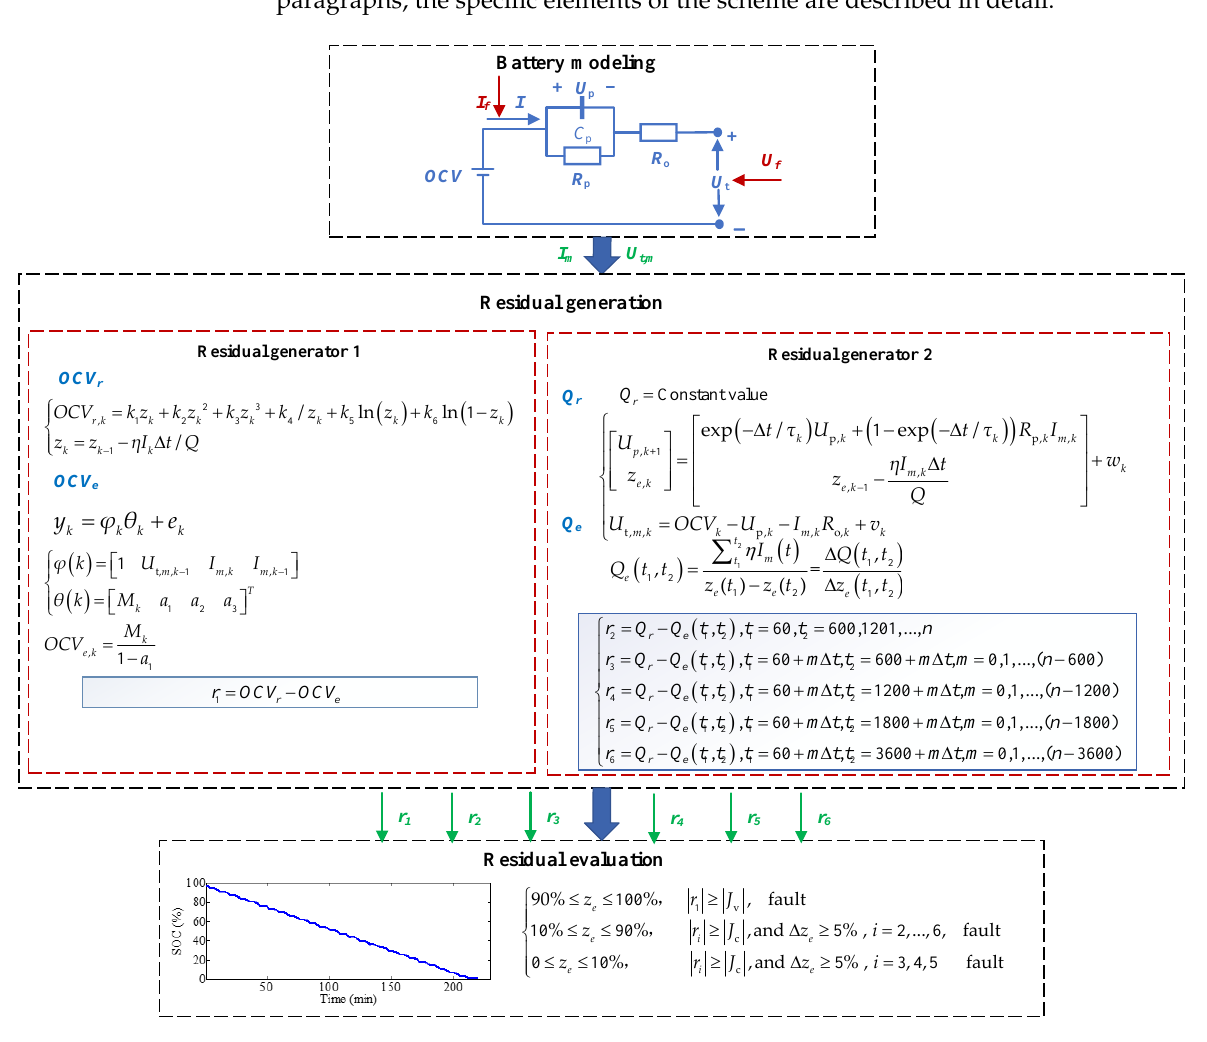
Figure 2. Sensor fault diagnosis scheme.